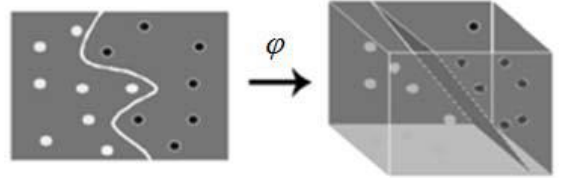
Figure 2: Linear Discrimination in Re-Description Space